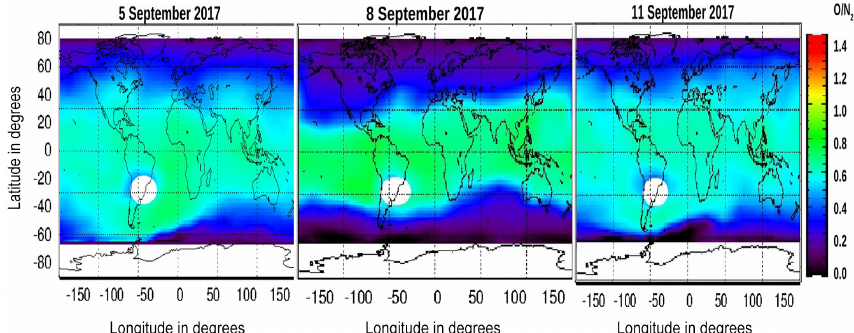
Figure 6. The thermospheric O / N 2 ratio obtained from the TIMED/GUVI instrument during the G4 category storm of 6–9 September